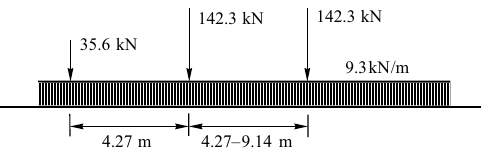
Fig. 4. Proposed nominal live loading (HL-93 live